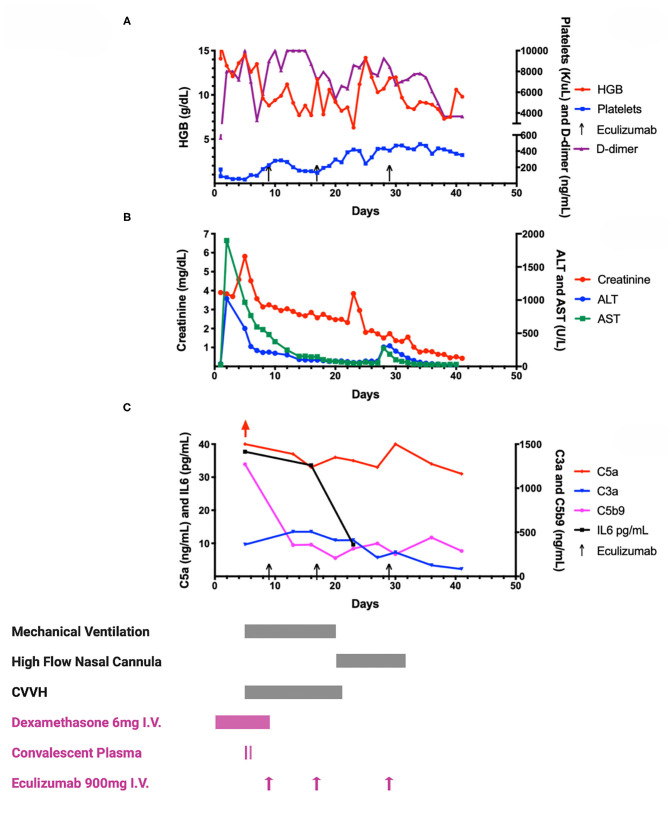
A graphic representation of laboratory and treatment measures. Graphs A-C illustrate various laboratory information throughout the patient's clinical course. Selected clinical interventions (respiratory support, renal replacement therapy, steroids, plasma and eculizumab) are shown along the bottom of this figure, and correspond to the timing of these interventions in relation to the graphs. (A) Hemoglobin (HGB), platelet and D-dimer trends throughout hospital course. Patient was admitted to intensive care unit on day 1. As shown in the graph, hemoglobin rapidly trended down along with thrombocytopenia which reached a nadir on day 5 and then steadily recovered following eculizumab and transfusion of platelets. His hemoglobin remained largely stable with a slow decline requiring packed red blood cell transfusions on days 15, 23, and 41. D-dimer was initially 565 ng/mL on day 1 of hospitalization, which rose rapidly over the next few days to peak at 10,000 ng/mL (upper limit of local laboratory analyses). The levels of D-dimer trended downwards around day 30, coinciding with the 3rd dose of eculizumab. The doses of eculizumab are indicated with arrows along the x-axis on days 9, 17, and 29. (B) Organ (renal and hepatic) function during COVID-19. Creatinine, Alanine Transaminase (ALT) and Aspartate Transaminase (AST) are shown in relation to the hospital stay of the patient. The peak in creatinine to 5.91 mg/dL on day 5 prompted the use of continuous veno-venous hemofiltration (CVVH) as shown in (C). The fall in creatinine was most appreciated with CVVH, and remained stable during his stay even after CVVH was discontinued on day 22. A brief rise in creatinine was noted after discontinuation of CVVH, which was not sustained, and creatinine levels decreased promptly without any additional intervention except continued eculizumab therapy. Hepatic function steadily improved following convalescent plasma and repeated doses of eculizumab. (C) Complement and cytokine analyses during hospital stay. Detailed analyses of multiple markers are in Table 1. This figure depicts the anaphylatoxin complement C5a over 40 ng/mL (red arrow, normal range 2.74–16.33 ng/mL) on day 5 coinciding with respiratory compromise. This level remained high in spite of administration of C5 inhibitor, eculizumab on day 9. The levels started to decline slowly with continue C5 blockade (doses on days 17 and 29). Elevated free C5 level on day 11 (see Table 1), after eculizumab dose on day 9 suggests incomplete blockade of C5 or continued complement activation upstream to C5. Plasma membrane attack complex (C5b9) of 1272 ng/mL which was five times the upper limit of normal (<244 ng/mL) dropped precipitously following eculizumab dose on day 9, and remained well-controlled through the stay. Levels of C3a followed a similar trajectory of C5a. An interesting phenomenon observed was significant drop in interleukin-6 (IL-6) levels following the second dose of eculizumab on day 17, which was closely followed by weaning of mechanical ventilation.